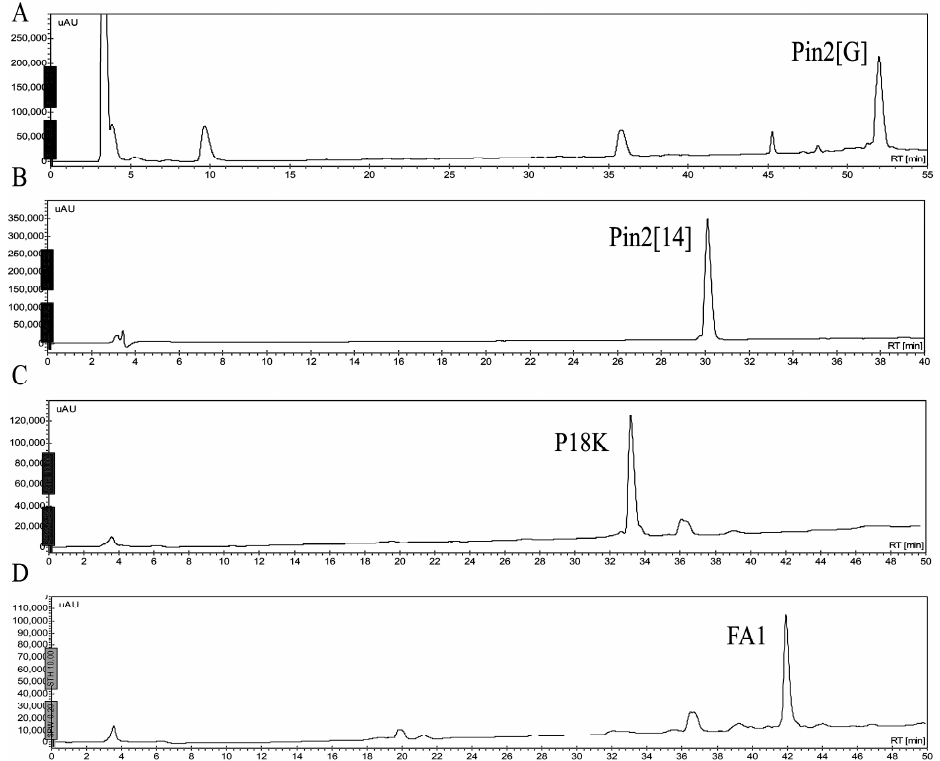
Figure 1. Reverse phase separation of synthetic peptides. They were separated using an analytical reverse phase C 18 column, at flow of 1 mL/min, with linear gradients from 0 to 60 of acetonitrile containing 0.1% of trifluoroacetic acid, in 60 min. ( A ) Pin2[G]; ( B ) Pin2[14]; ( C ) P18K; and ( D ) FA1.